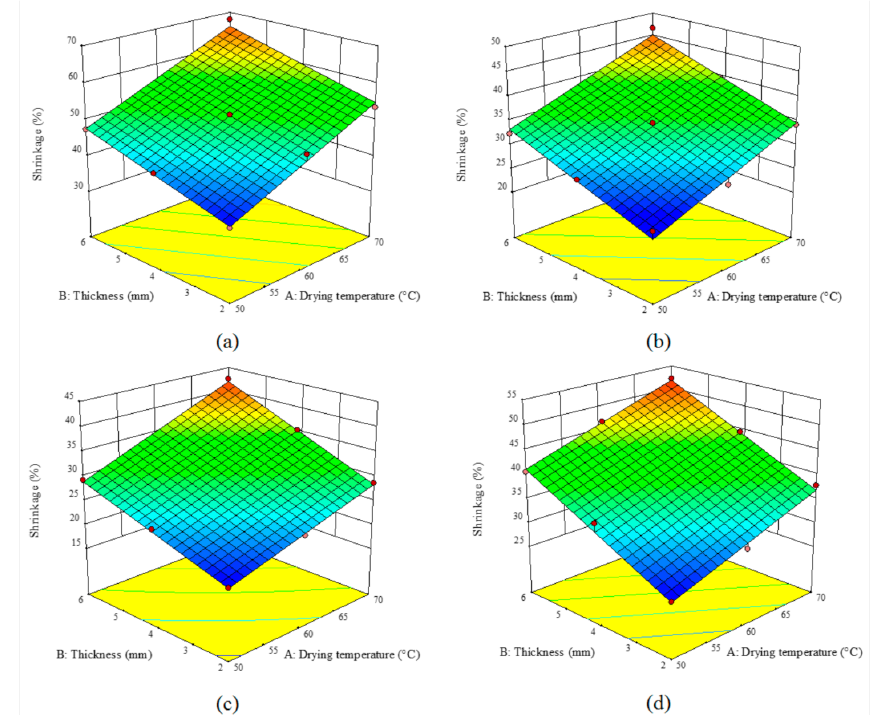
Figure 6. Effect of the drying temperature and sample thickness on the shrinkage (%) of the turnip slices dried under an HCIR dryer with various pretreatments ( a ) control, ( b ) microwave, ( c ) ultrasound, and ( d ) blanching.